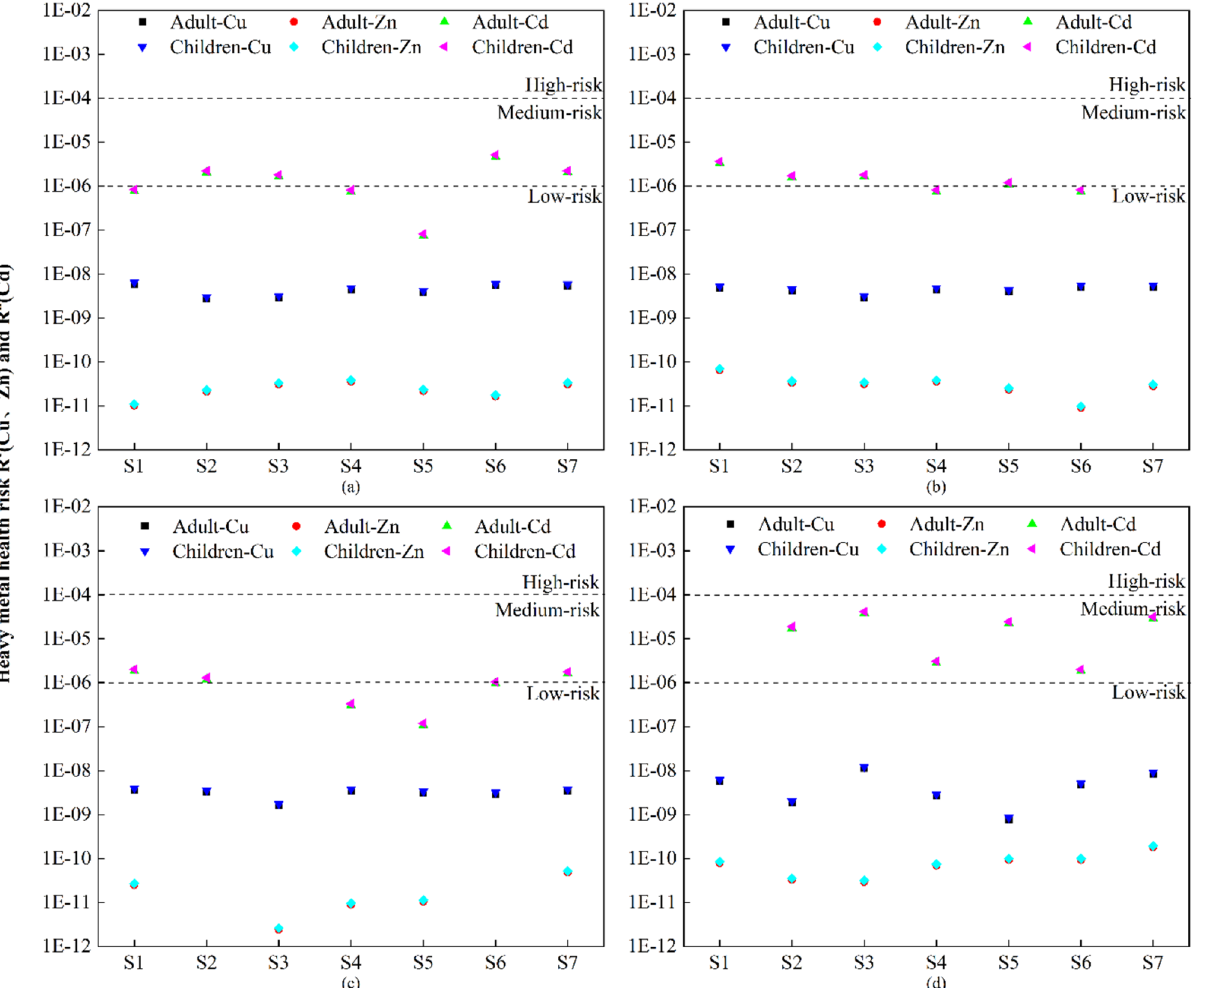
Figure 7. Risk assessment of heavy metal human health in Yitong River, Changchun. ( a – d ) are health risk assessments of heavy metals for adults and children in June, August, October and December,